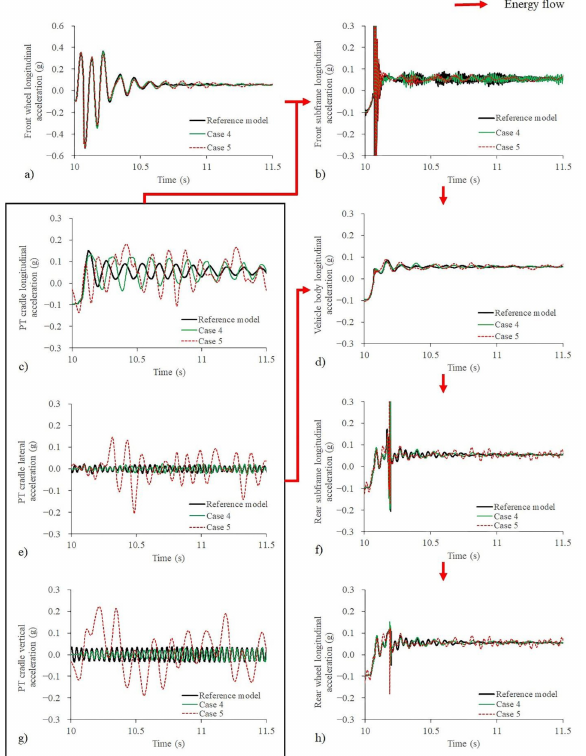
Figure 14. Tip-in event components accelerations EPA on the tarmac and decoupled PT cradle rubber mount properties: ( a ) front wheel longitudinal; ( b ) front subframe longitudinal; ( c ) PT cradle longitudinal; ( d ) vehicle body longitudinal; ( e ) PT cradle lateral; ( f ) rear subframe longitudinal; ( g ) PT cradle vertical acceleration; ( h ) rear wheel